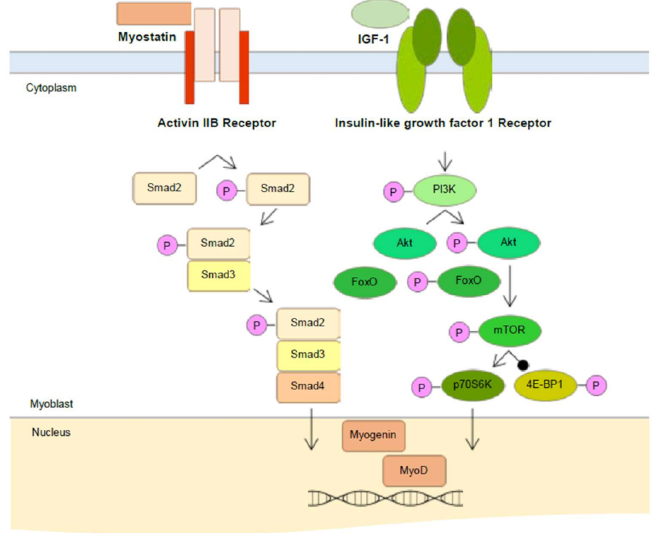
Figure 11. Mechanisms of Myostatin and IGF-1 mediated regulation of skeletal muscle